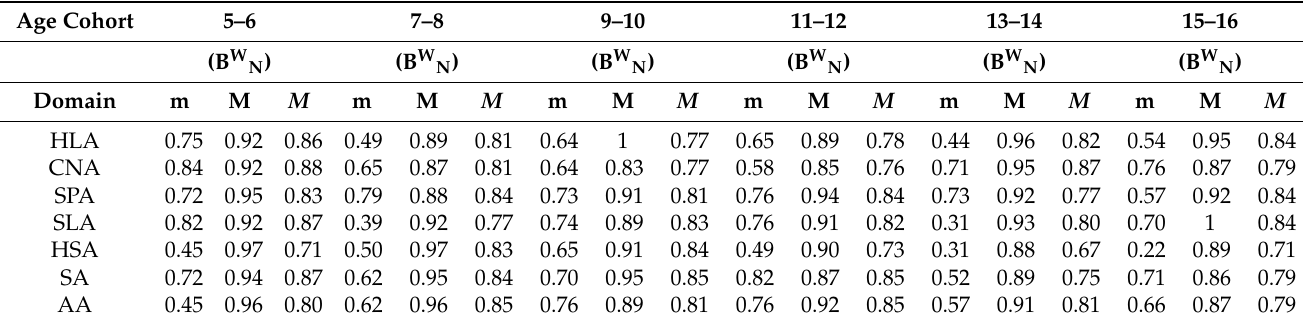
Table 4. Agreement size among judges (domains and age